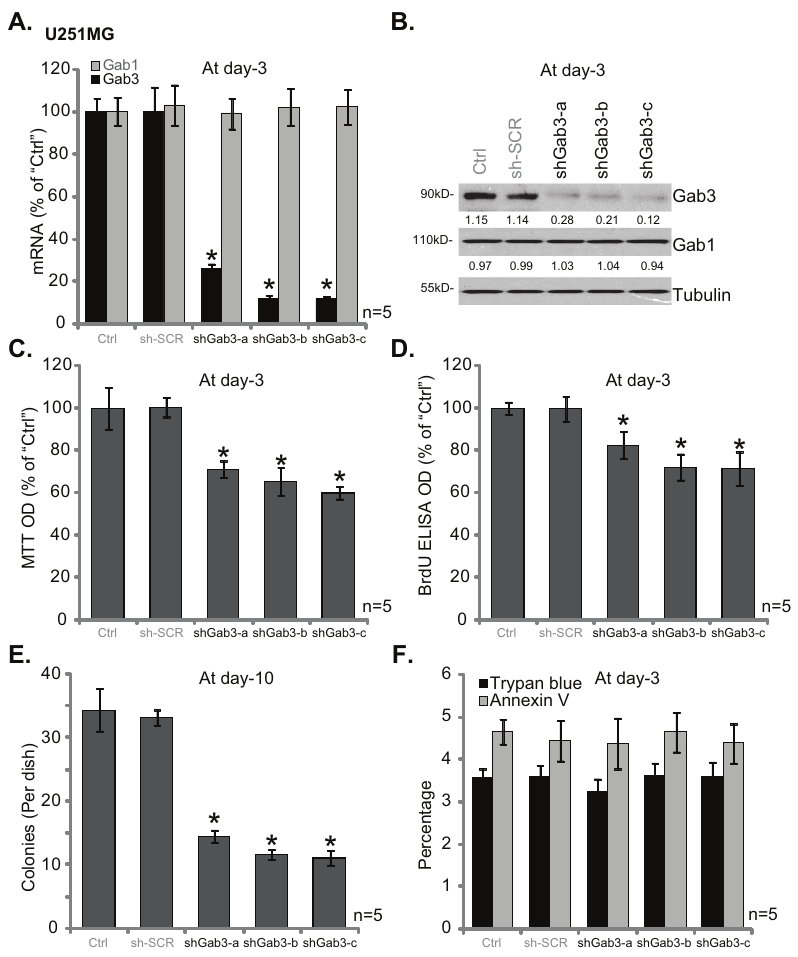
Fig 2. Gab3 knockdown by shRNA inhibit U251MG glioma cell proliferation. Stable U251MG glioma cells, expressingGab3 shRNAs (“shGab3-a/-b/-c”) or scramble control shRNA (“sh-SCR”), as well as the parentalcontrol (“Ctrl”) U251MG cells, were subjectedto qRT-PCR assay (A) and Western blotting assay (B) of listed genes; Cell proliferation was tested by MTT assay (C), BrdU ELISA assay (D) and Clonogenicity assay (E); Cell death (trypan blue stainingassay) and apoptosis(AnnexinV FACS assay) were also tested (F). Relativeexpressionof listed proteins was quantified (vs. Tubulin, B). For all these assays, the exact same numberof cells of different backgrounds were initiallyplated into each well/dish.Data were presented as mean ± SD. * p < 0.05 vs . “Ctrl” cells.